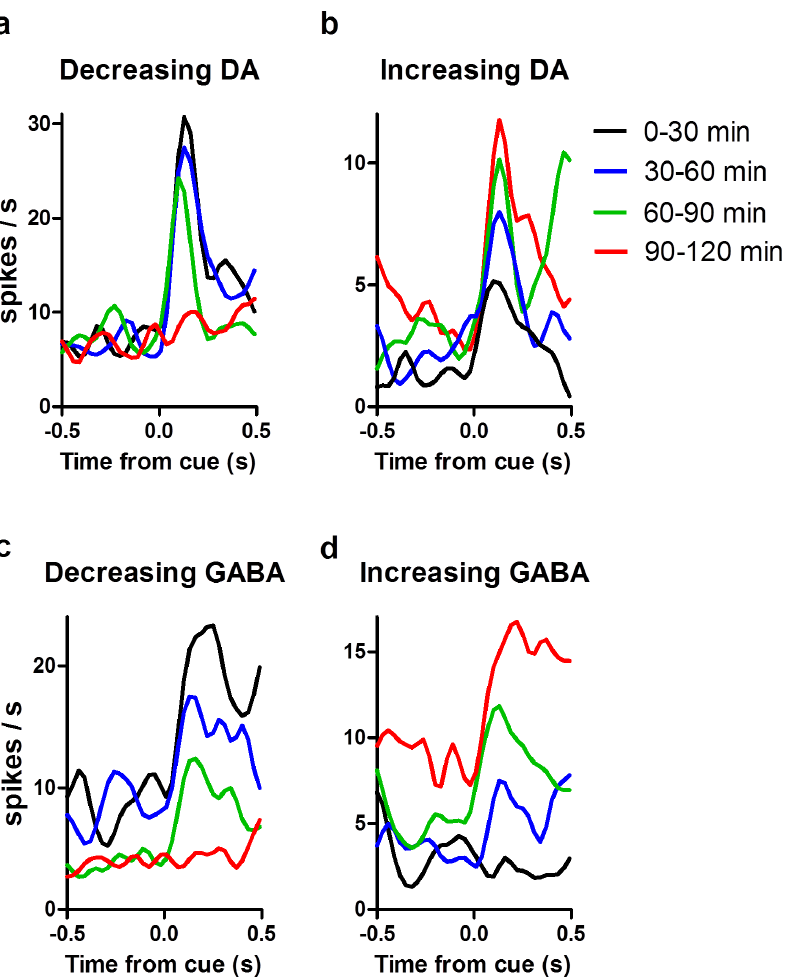
Figure 6. Motivational modulation of phasic responses to reward cue. Motivational modulation of DA and GABA activity in SN. ( a ) Sample PSTH illustrating the motivational shift in phasic cue response of decreasing ( a ) and increasing ( b ) DA neurons separated into four 30 min blocks (bin size =30 ms). GABA neurons also showed similar decreasing ( c ) and increasing ( d ) motivational modulation.